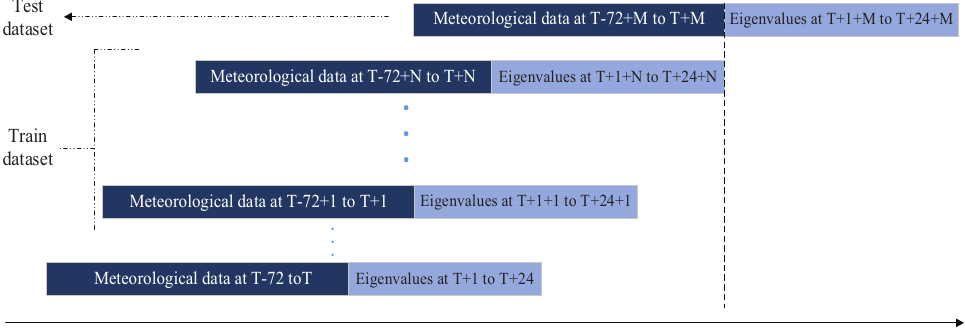
Figure 2. Schematic diagram of data time sliding window